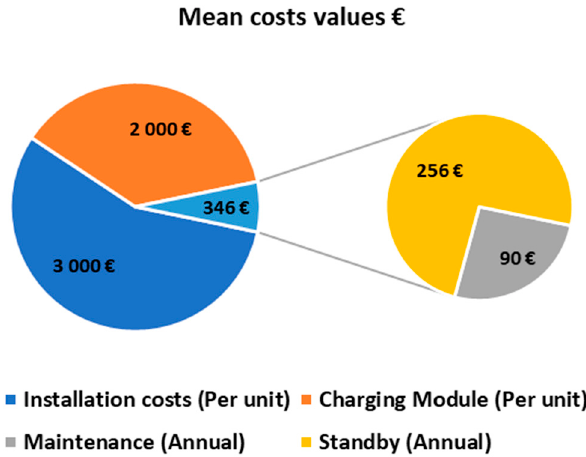
Figure 1. Mean costs inherent to each charging station. Table 4. Standby measurements result of the charging point Efacec